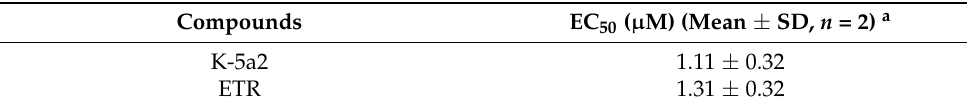
Table 2. Inhibitory activity of K-5a2 against HIV-1